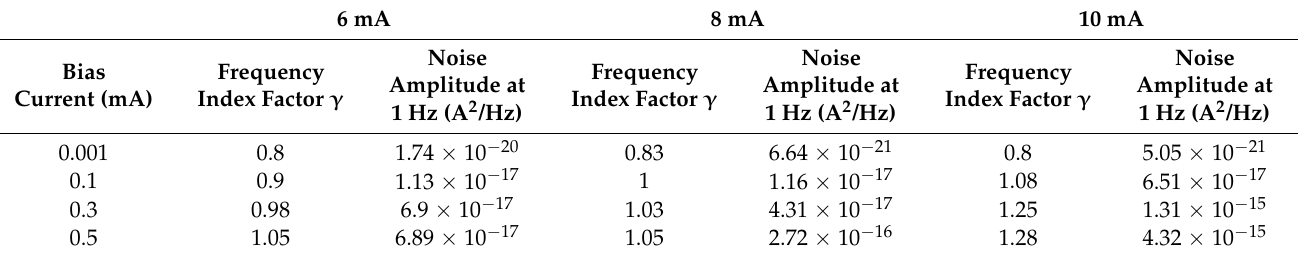
Table 2. The frequency index factor and noise amplitude at different bias